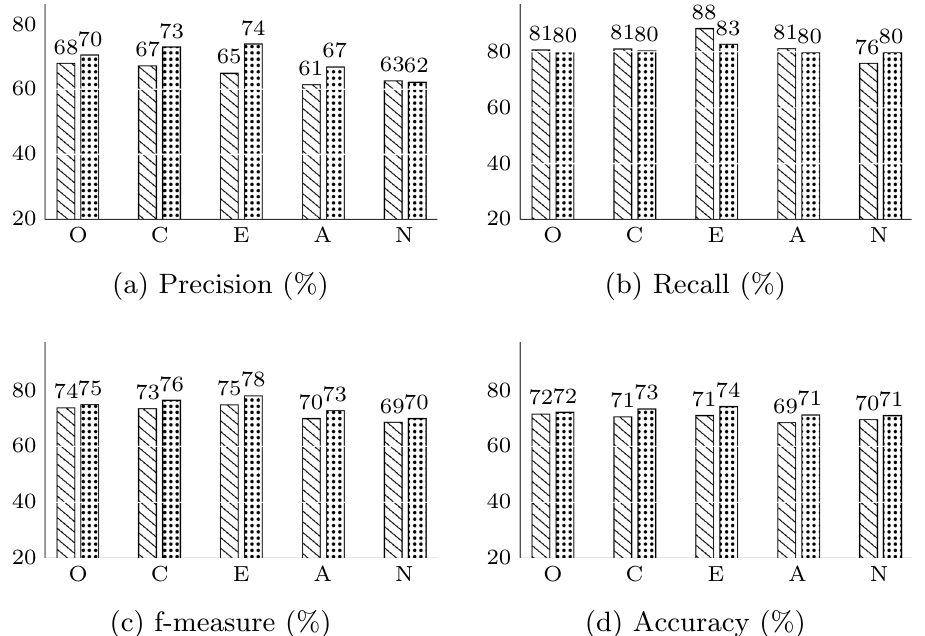
Figure 5. The comparison of four evaluation metrics for both classification techniques provided by KGrAt- Net, namely knowledge graph attention network classification (depicted by ) and knowledge graph attention network along with knowledge graph embedding classification (depicted by ). The values are